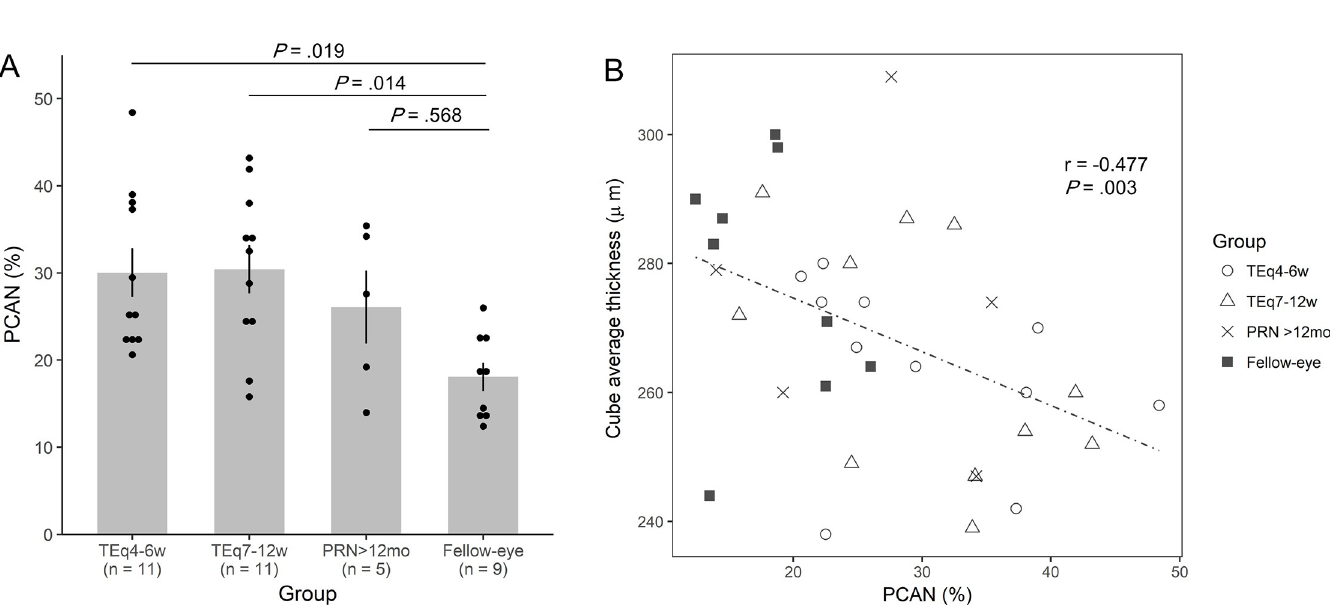
PLOS ONE | https://doi.org/10.1371/journal.pone.0218889 June 25,